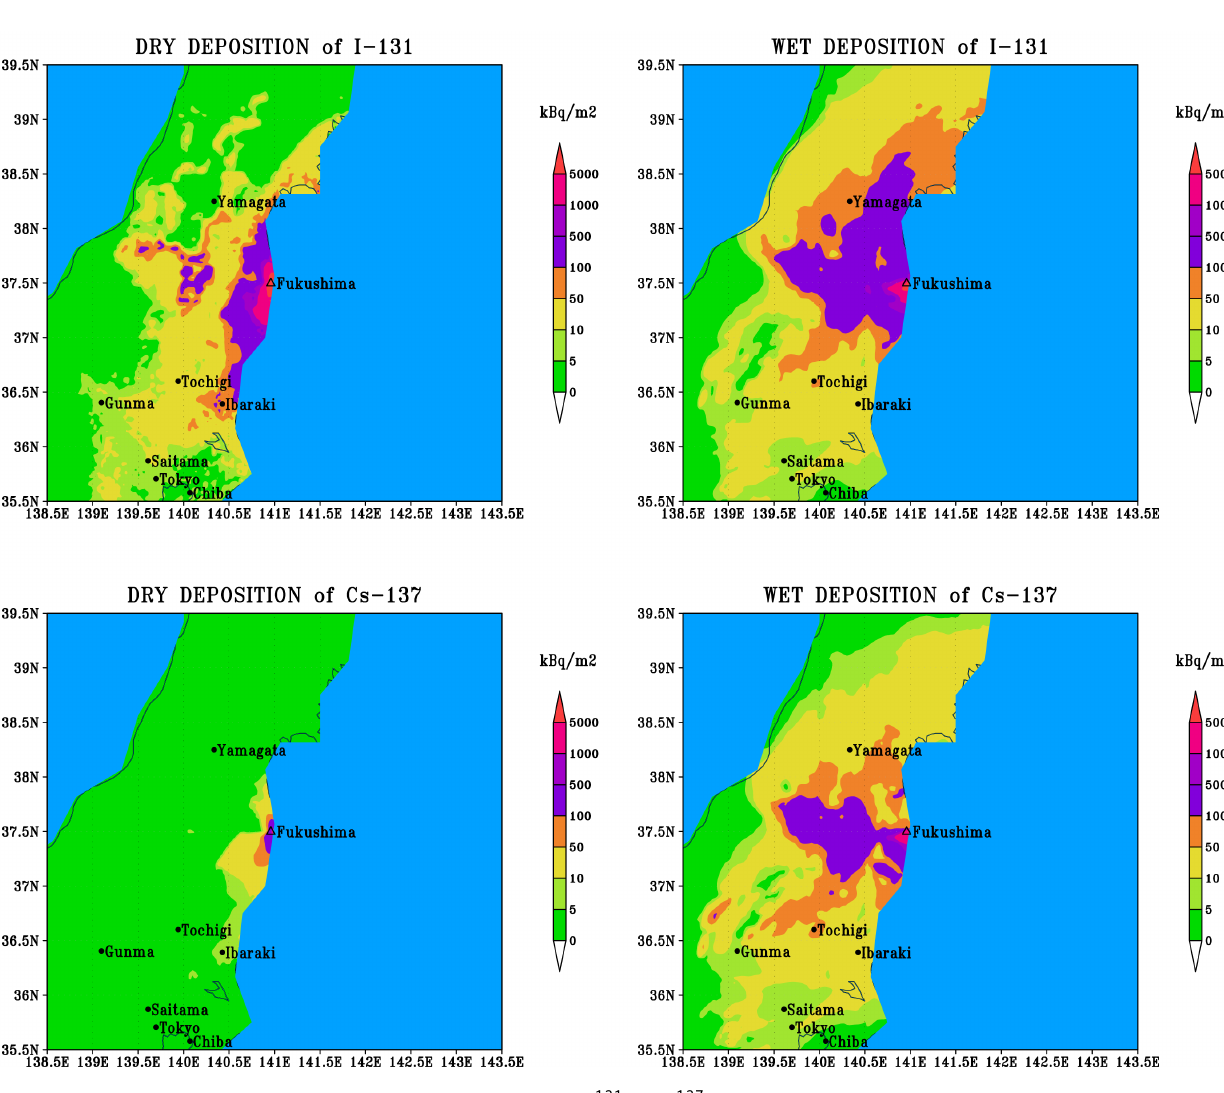
Figure 10. Distribution of accumulated dry and wet depositions of 131 I and 137 Cs over domain 2 in the reference case (REF) from 11 to 31 March. The upper panels show the accumulated dry and wet deposition of 131 I; the area with dry deposition over 100kBqm − 2 is concentrated near the source and is much smaller than the area with wet deposition over 100kBqm − 2 . The lower panels show the accumulated dry and wet deposition of 137 Cs, the pattern of dry deposition is quite different from that of 131 I and most of the areas have values lower than 5kBqm − 2